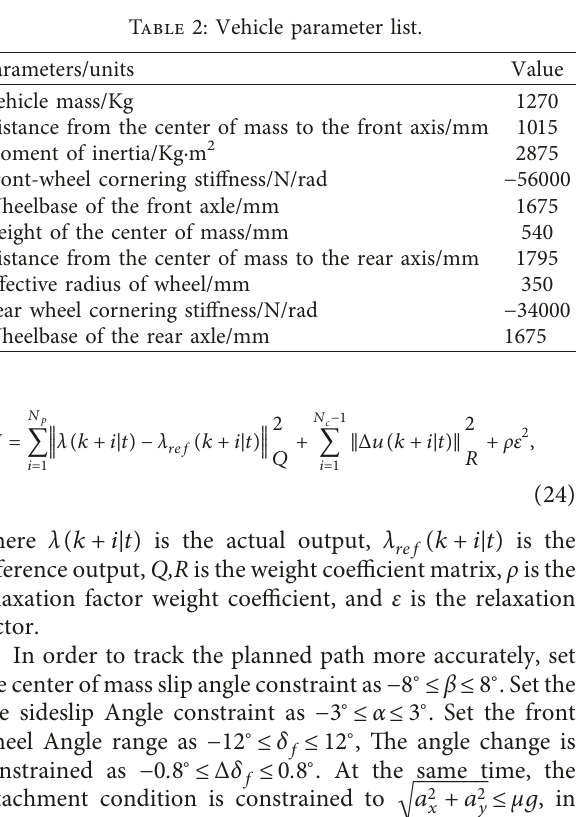
Figure 14: Three degrees of freedom vehicle dynamics model.